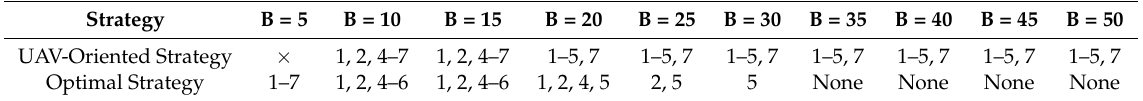
UAV-oriented strategy is infeasible for that battery